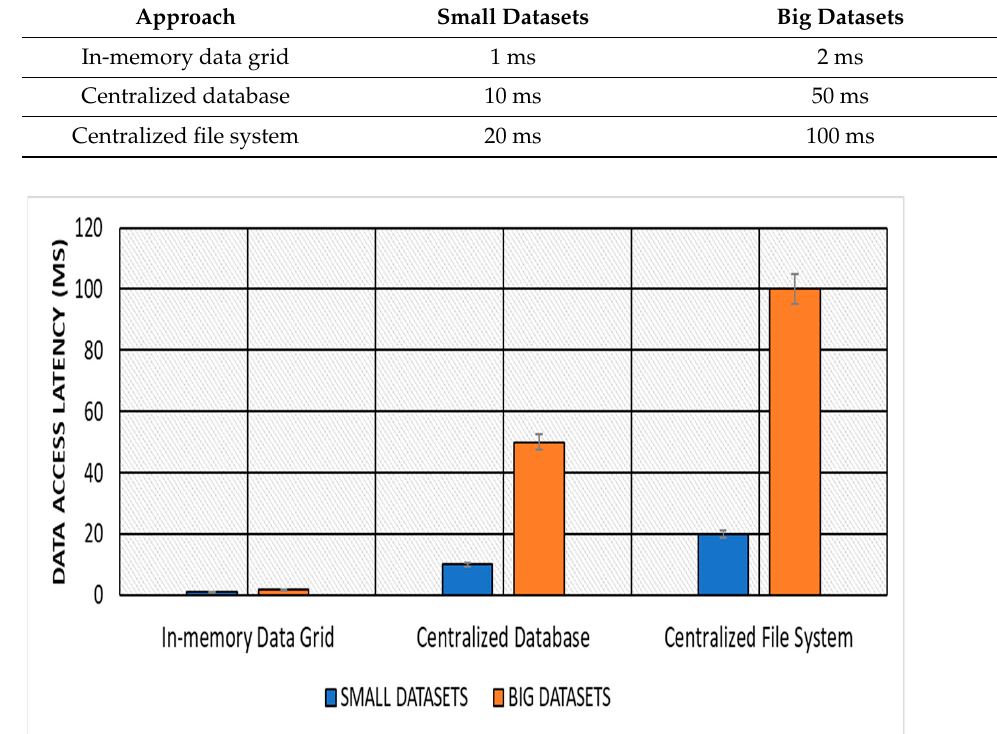
Table 4. Data access latency of small and large datasets for different approaches.